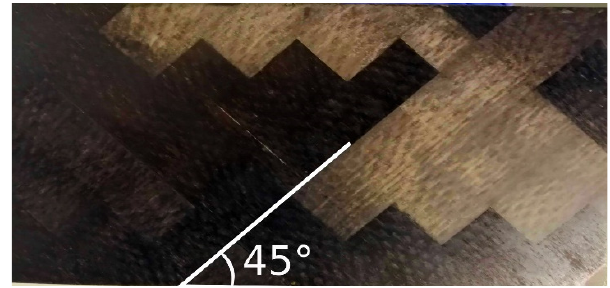
removing from the stainless-steel